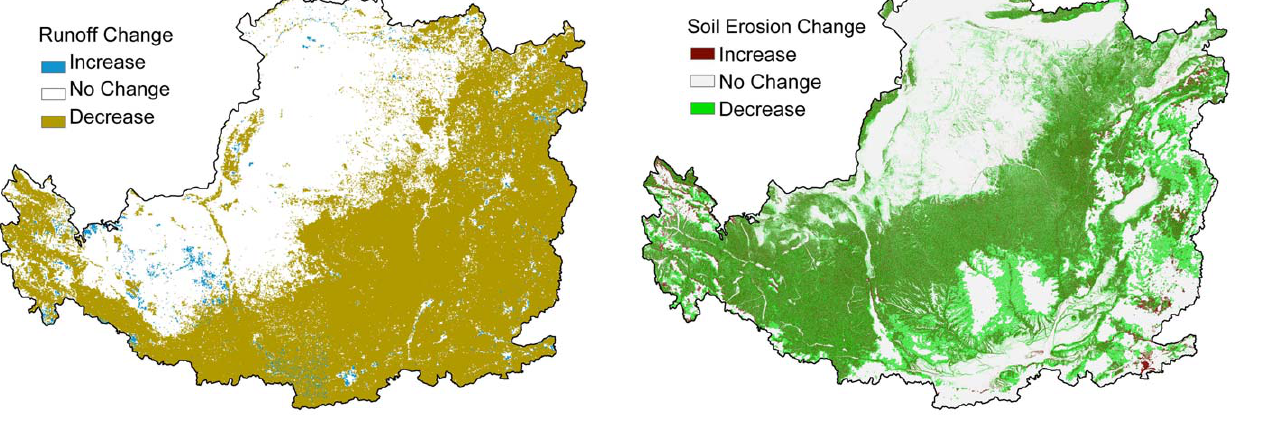
Figure 6. The change in soil erosion in the Loess Plateau region from 2000 to